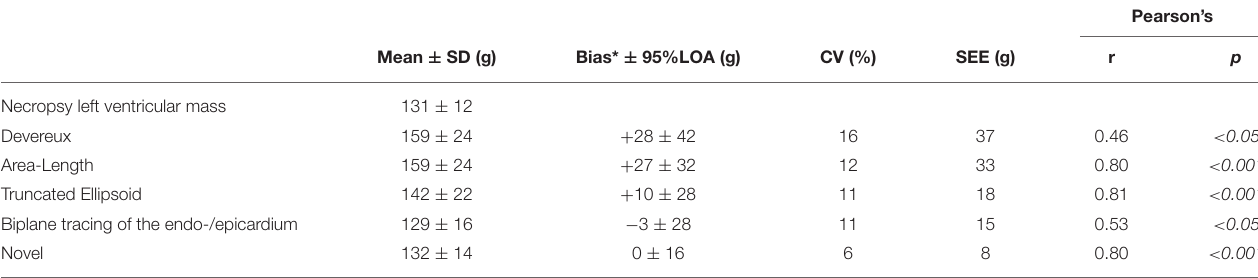
TABLE 3B | Accuracy of various methods for left ventricular mass quantification among the pigs with 100% feasible measurements ( n =